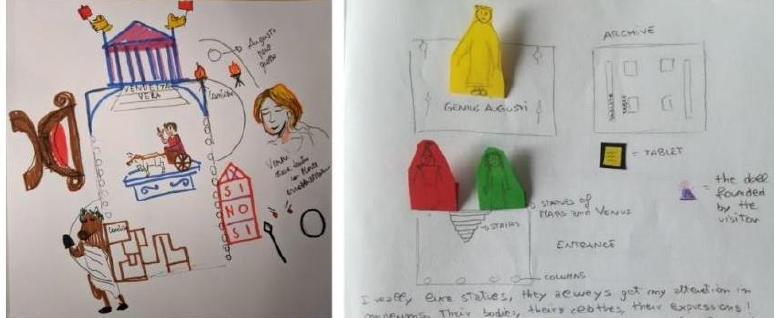
Figure 4. Some of the resulting drawings (d), from group A ( left ) and E ( right ).